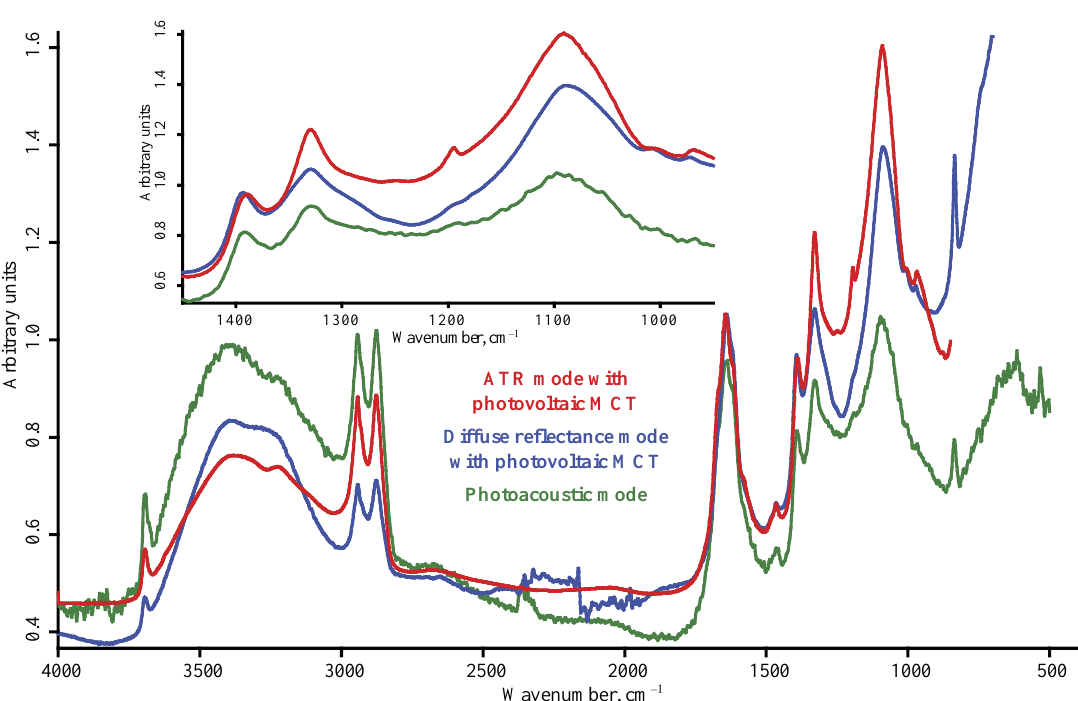
Figure 10. ATR mode, PL-D-G-01P nanodiamonds; red, LN-MCT photovoltaic detector; blue, DLaTGS detector; ( a ) 4000–2500 cm −1 , ( b ) 2000–800 cm −1 range. Spectra were not smoothed but normalized to maximize each spectrum.